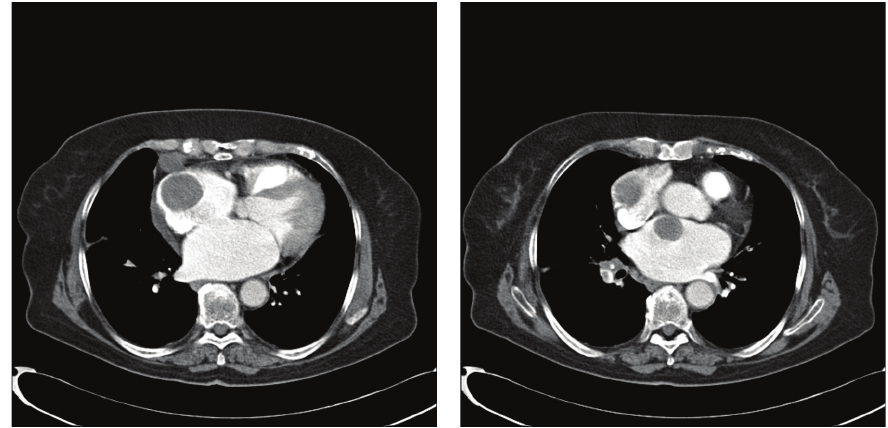
Figure 3: Thoracic CT demonstrates two masses with biatrial cardiac metastases of malignant melanomas in uterine cervix: one is 36 × 37 mm and the other is 26 × 20 mm in right and left atriums.